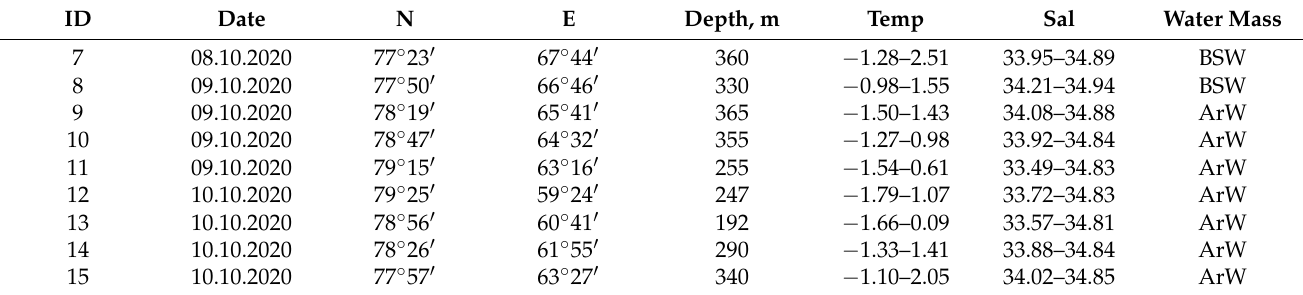
Figure 1. Location of sampling stations in the northeastern Barents Sea, in October 2020. Table 1. Location and hydrology of sampling stations in the northeastern Barents Sea, in October 2020